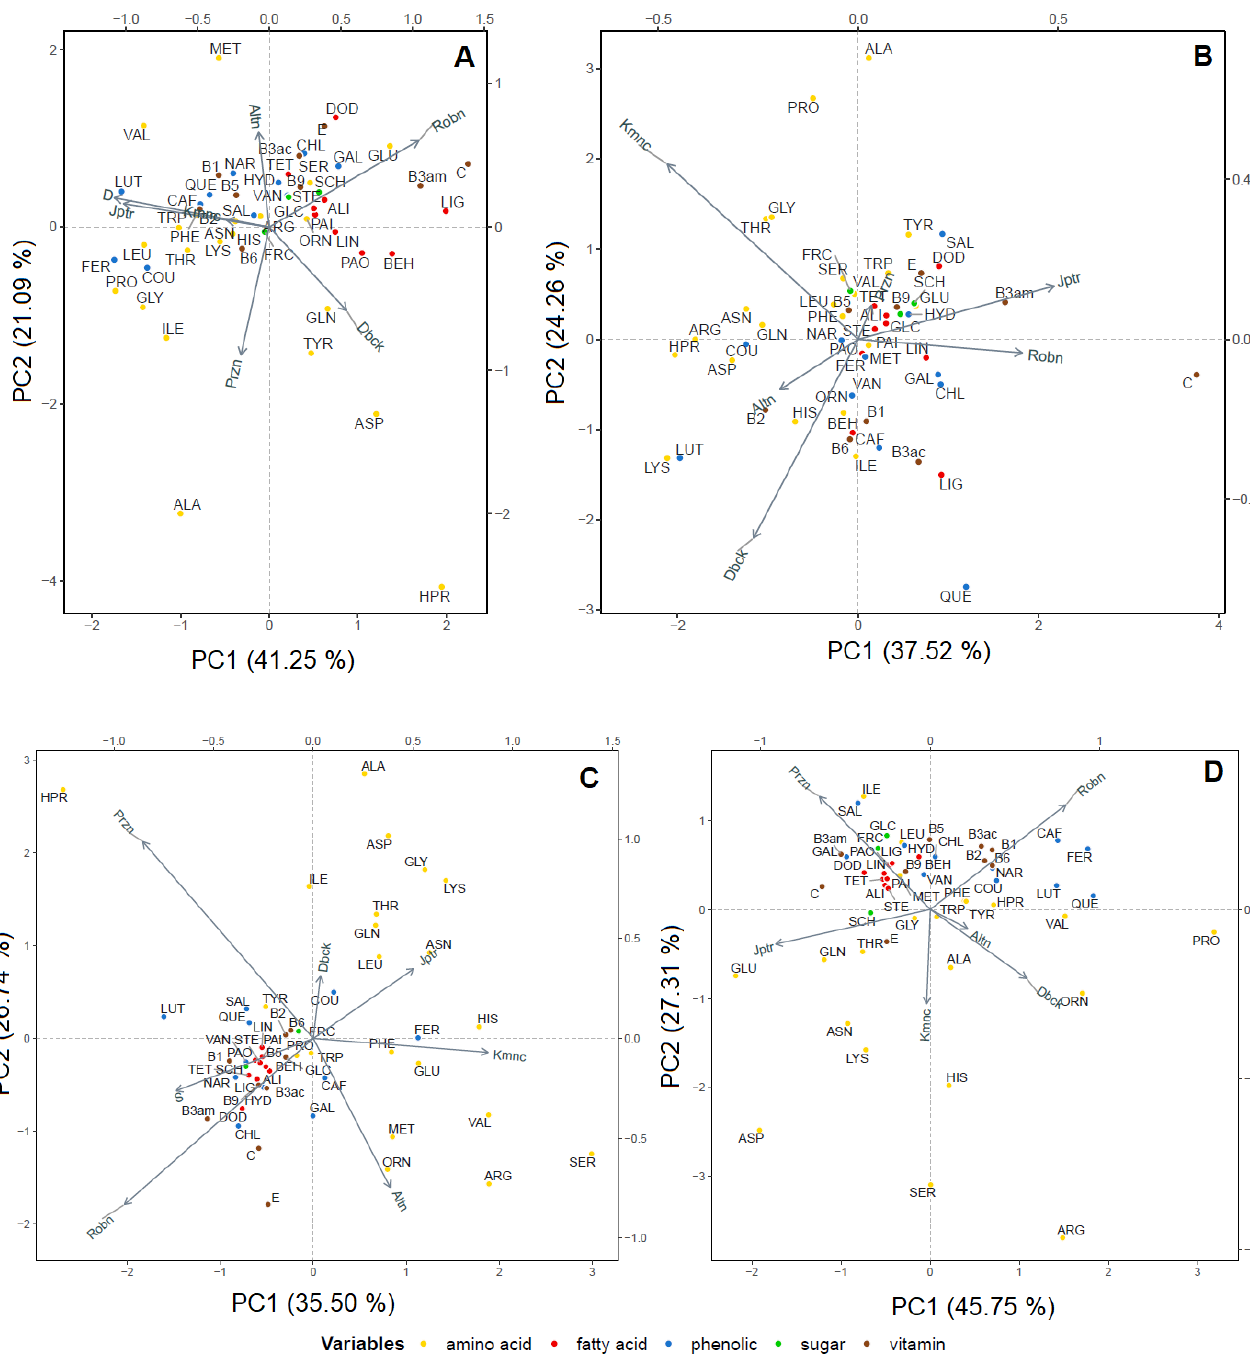
Figure 5. PCA biplots for independence ( A ) and interaction tables ( B ) for the case of drought vs. control, and the case of salt stress vs. control, ( C ) and ( D ), respectively. The points are labeled with the abbreviated variables ’ names. The labels of the arrows substitute the names of the coordinates: D, respectively S, stands for 𝑧 1𝑐 ( A , C ); the abbreviations of varieties refer to the superscript l in coordinates 𝑧 1𝑟(𝑙) ( A , C ), respectively coordinates 𝑧 1𝑂𝑅(𝑙) ( B , D ).